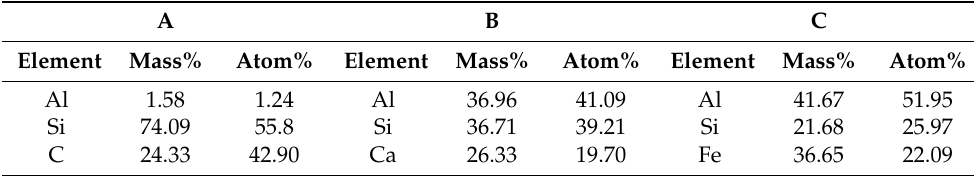
Figure 7. SEM-EDS patterns of the residue; ( a ) SEM image of the residue with three sections, ( b ) EDS of section A, ( c ) EDS of section B, ( d ) EDS of section C. Table 4. Elemental compositions of the sections A, B and